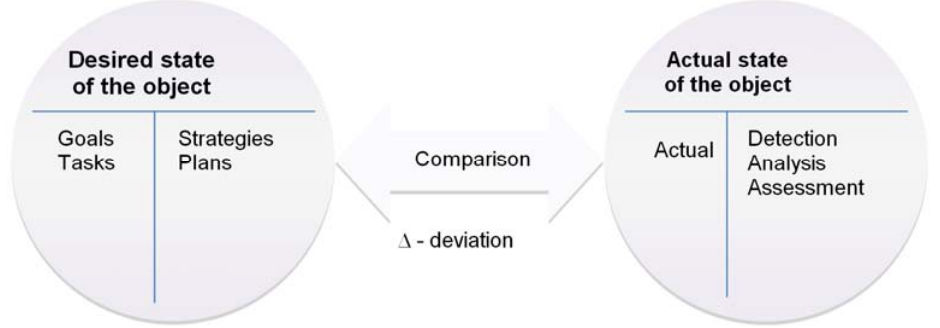
Fig. 5. The simplest model (basic procedure) of control.